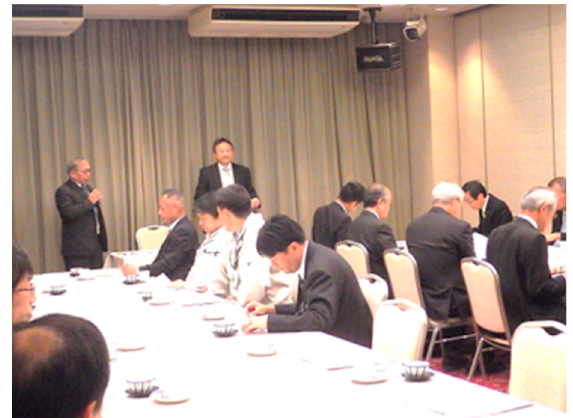
Figure 8. Presentation by the author at the annual meeting of “Disaster Mitigation Council in the Fuji River Basin” held on 24 April 24 2018.